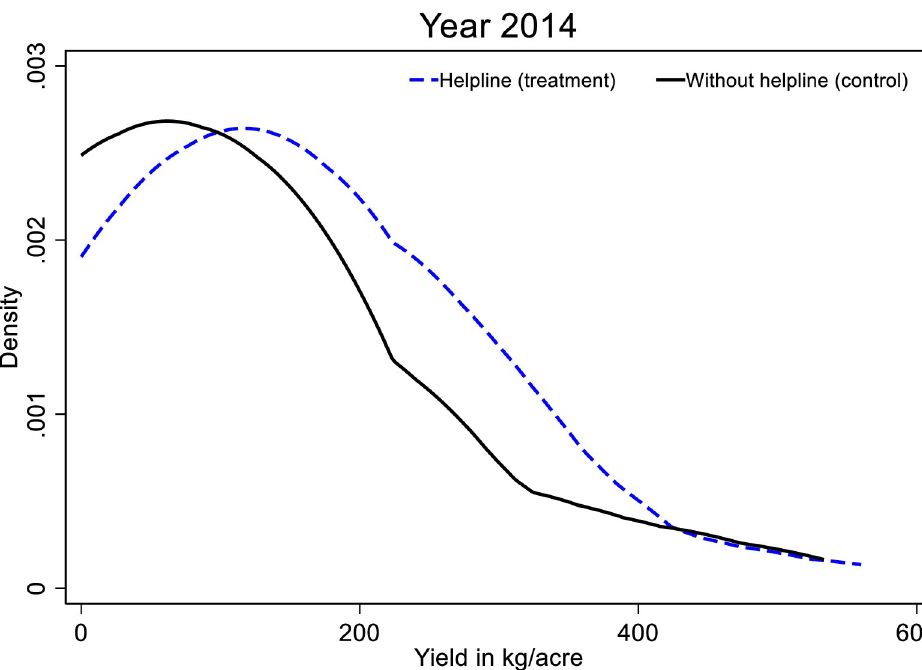
Fig 2. Kernel density of plot-level pigeon pea yield by treatment status. Notes: Density is estimated across all the pigeon pea plots. The dashed line is the density for all the pigeon pea plots cultivated by farmers who received the hotline number. Solid lines are density for all the pigeon pea plots grown by control farmers who did not receive the hotline phone number.